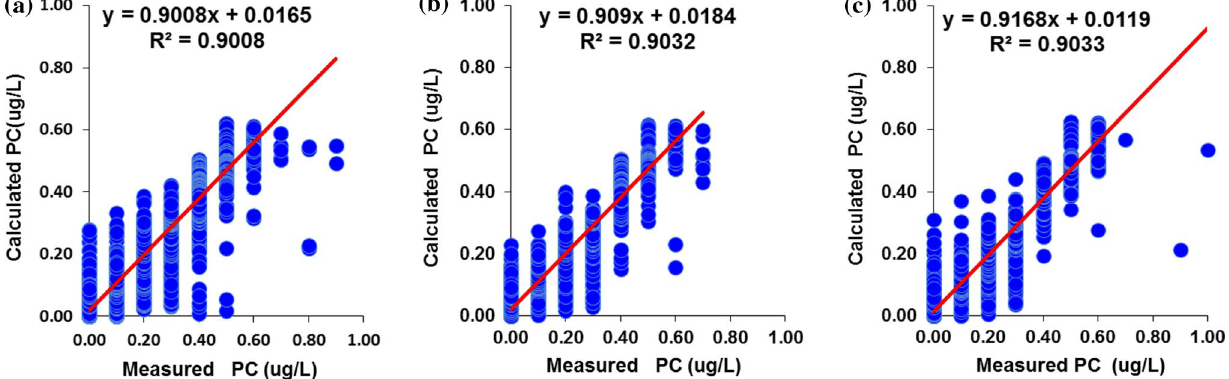
Fig. 9 Scatterplots of estimated versus measured values of PC for ANFIS_SC (M1) model: a training, b validation and c test data—station